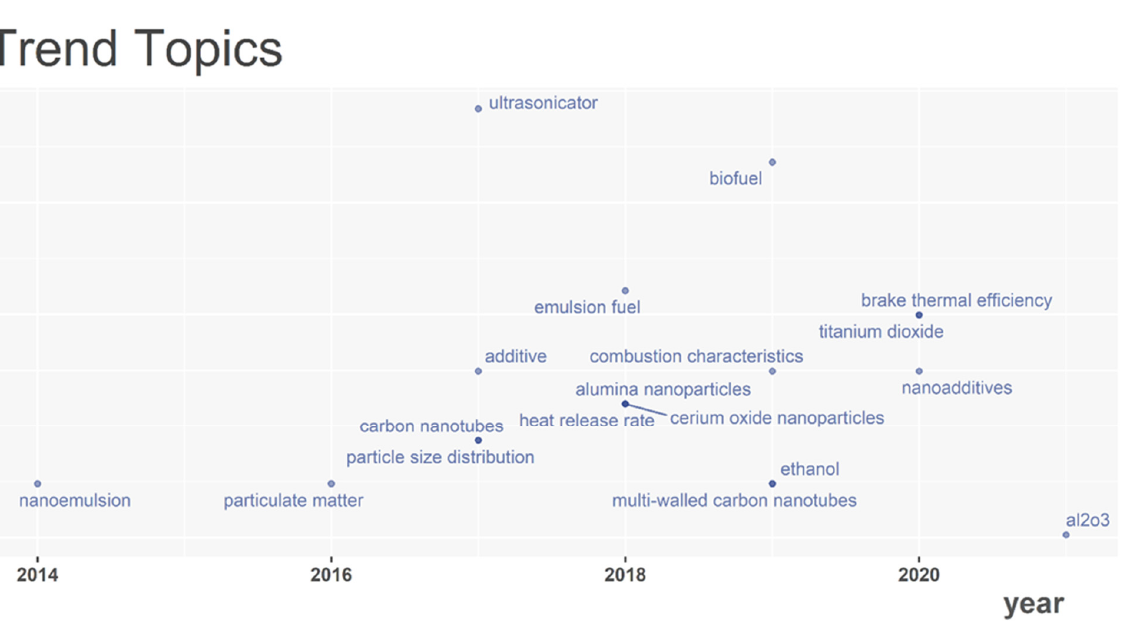
Figure 2. Analysis of topic trends for research on nanoparticles as additives for biodiesel/vegetable oil/alcohol–diesel blends between 2014 and 2021.